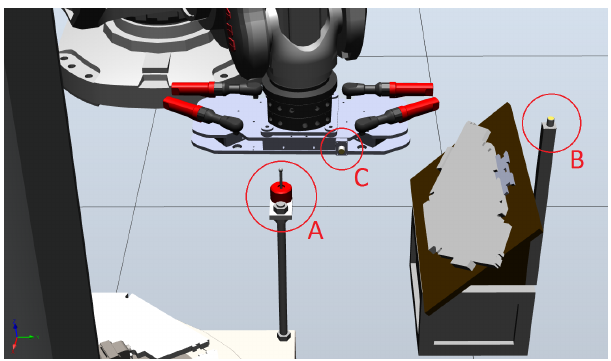
Figure 3. CAD model of the robot cell, showing the placement of the three main sensors used during measurements. In view is the touch probe ( A ), the fixed inductive proximity sensor ( B ) and the tool-mounted inductive proximity sensor ( C